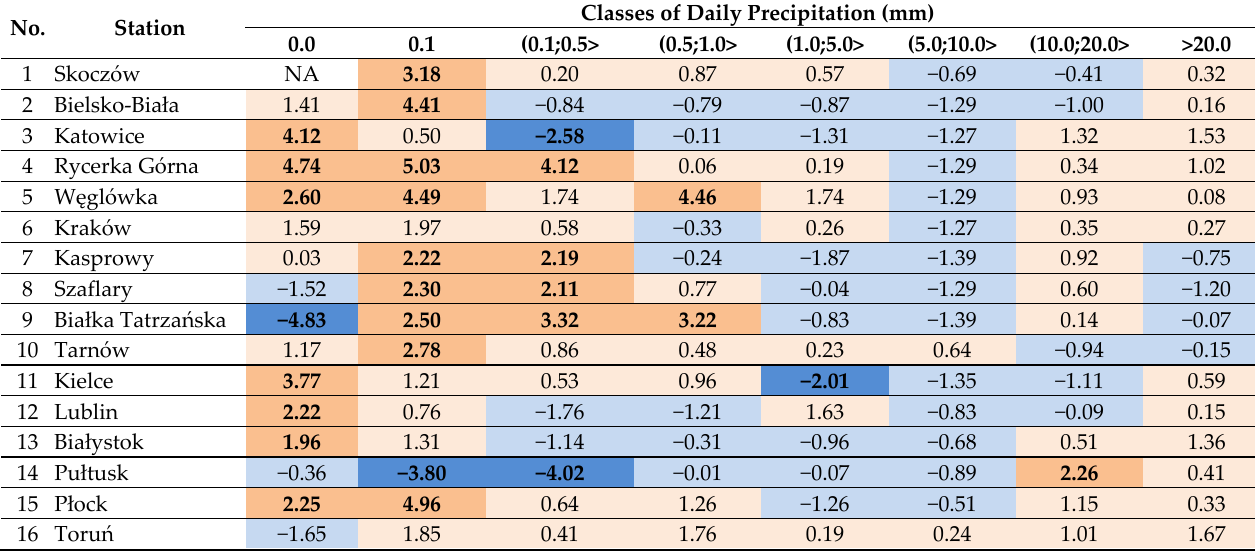
Table 12. Results of the Mann test ( uF statistics) for trends in precipitation structure in the winter season; orange colour denotes positive uF values, blue colour negative. Numbers in bold indicate statistically significant changes at α level 0.05. No.